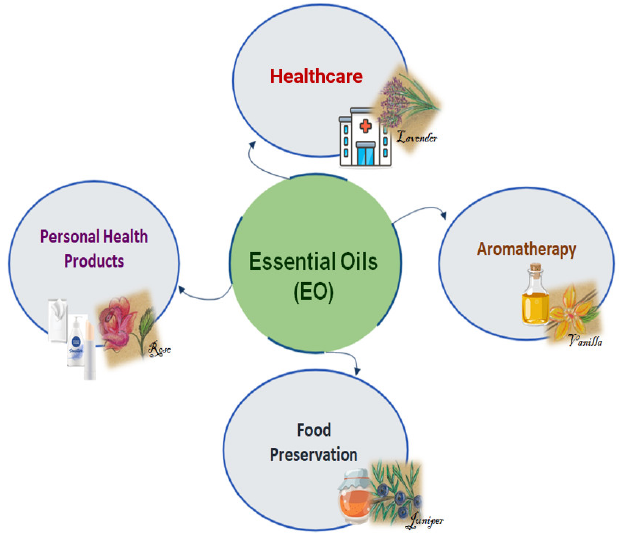
Figure 2. Some EO Figure 2. Some EO applications.